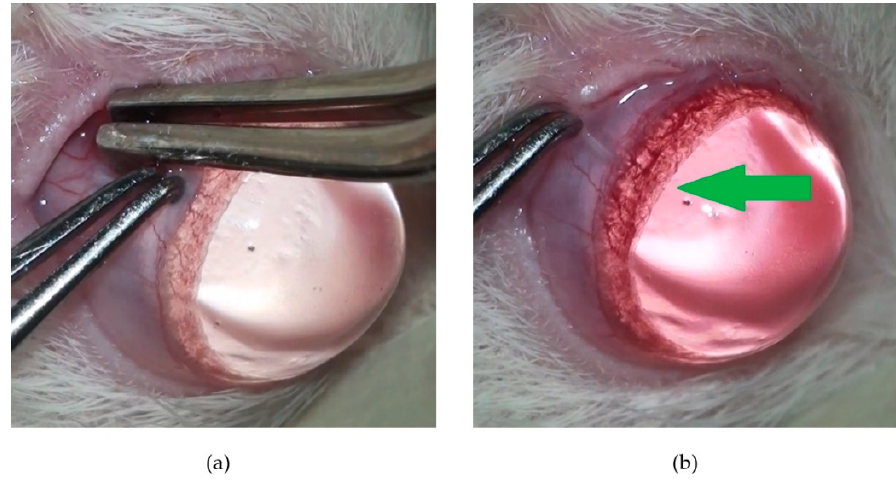
Figure 10. Photo of a rat ocular globe during the microsurgical procedure: ( a ) before the cauterization of the dorsal episcleral vein, showing normal iris vascularization; ( b ) after the cauterization of the dorsal episcleral vein, showing an evident generalized iridal congestion (green arrow).